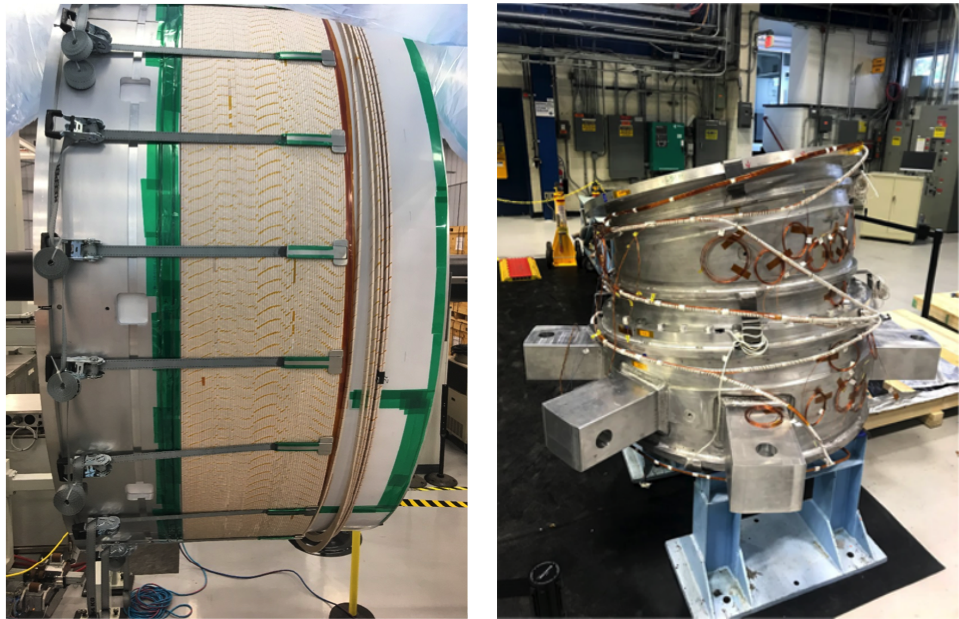
Figure 14. (Left) picture of the coil winding carried out on one of the parts of Detector Solenoid magnet, (right) TS units number 4 during measurements at the HAB